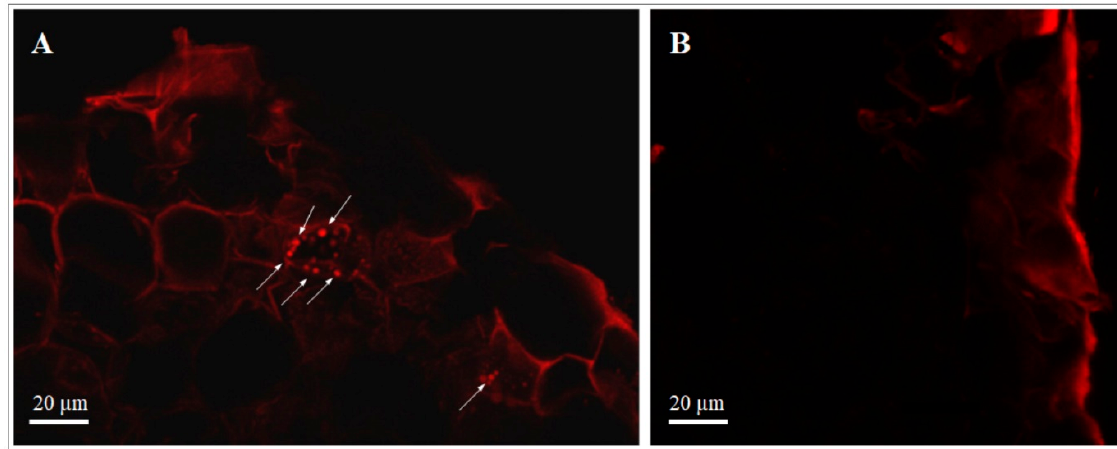
Figure 2. Images under the confocal microscope of roots of rooted grapevine cuttings inoculated with ( A ) dsRed-tagged P. protegens MP12 one week after inoculation. dsRed-tagged bacteria (arrows) were visualized in the cortex and near the endodermis barriers. ( B ) Fluorescent microorganisms were not observed in the control roots (uninoculated cuttings).